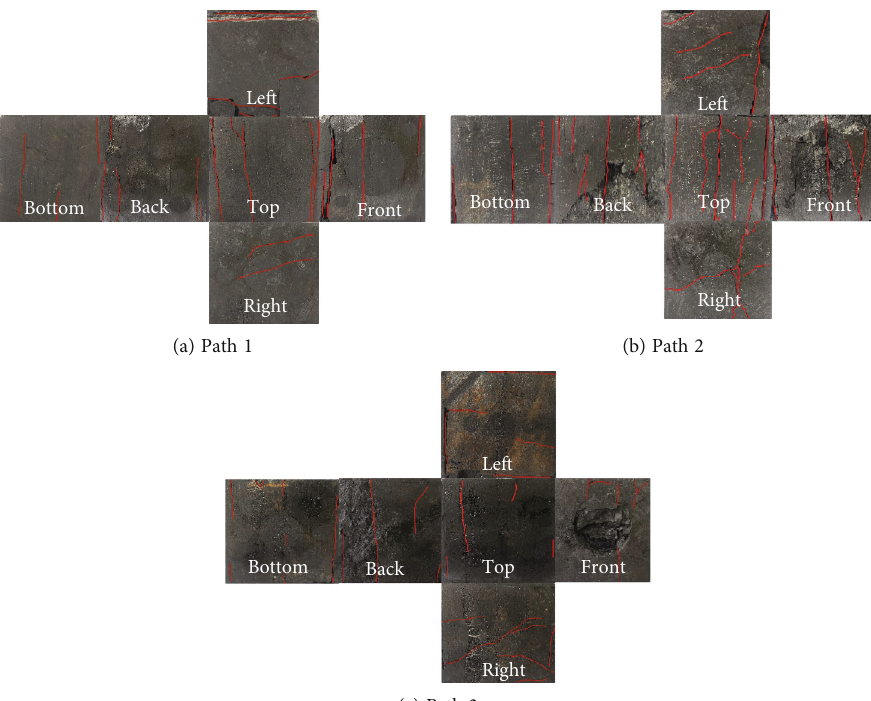
Figure 5: Deformation and damage characteristics of coal bodies in di ff erent paths.